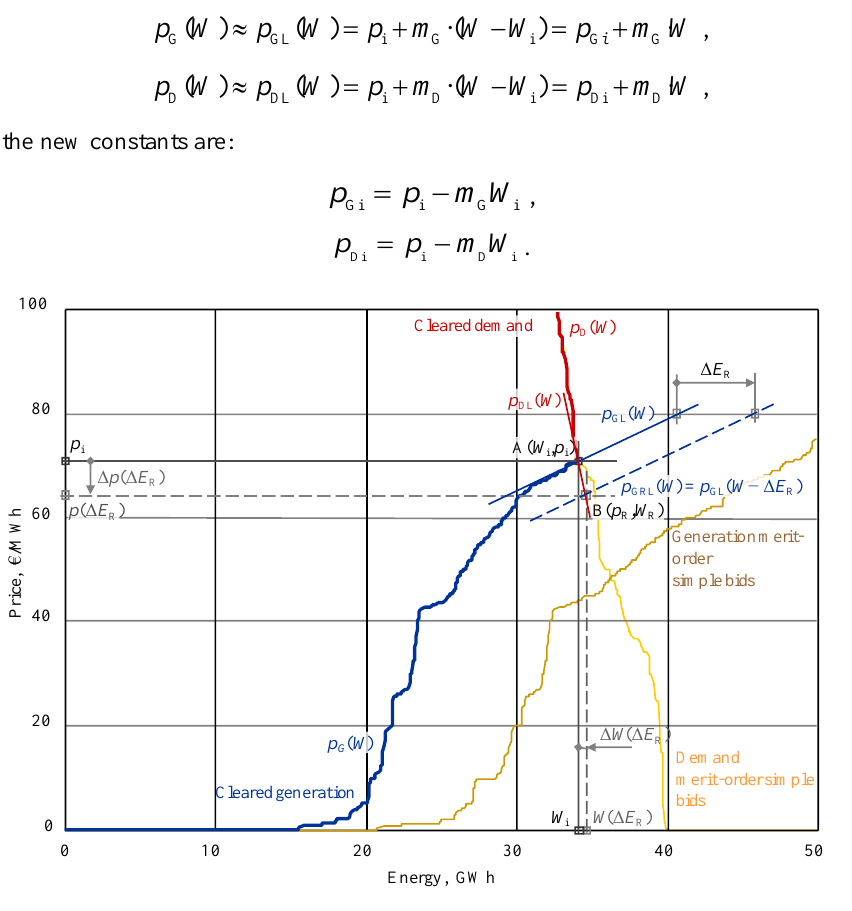
Fig. 1. Merit-order generation , p G (W), and demand, p D (W), curves for a peak hour on a working day in winter corresponding to the Iberian market [16]. Changes in the generation curve and market clearing point due to the integration of an amount of renewable bids, Δ E R , at very low